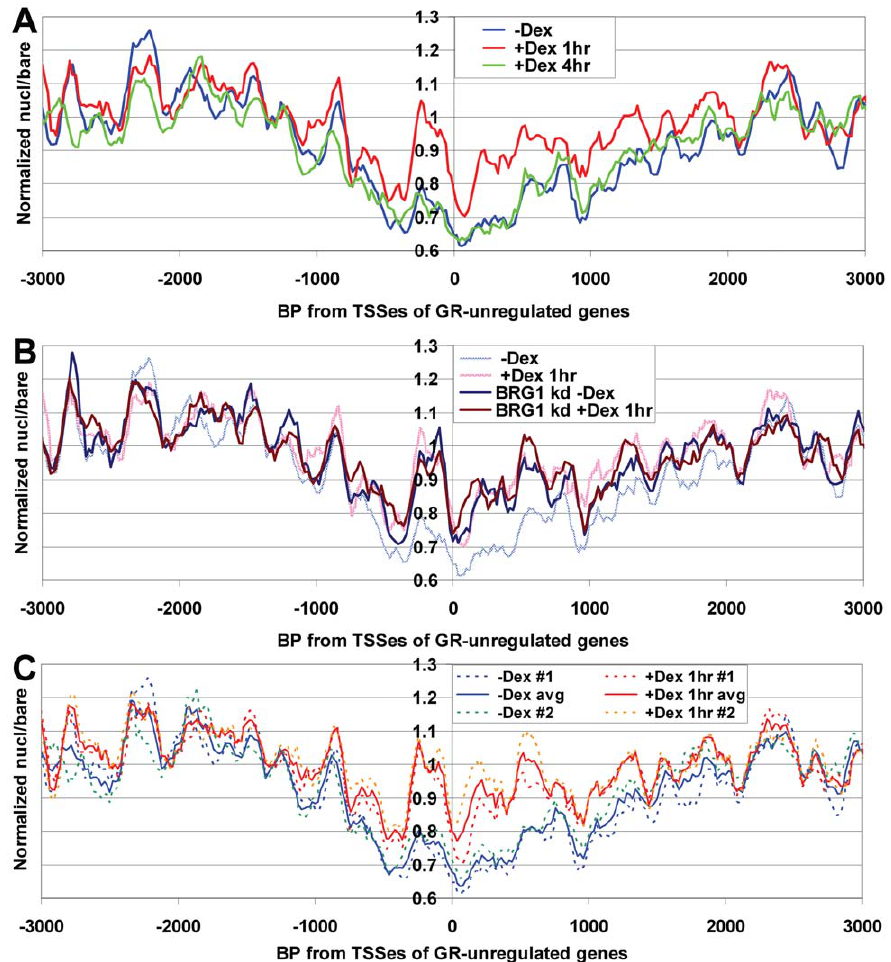
Figure 4. 1 hr Dex treatment increases nucleosome occupancy at GR-unregulated promoters. ( A ) & ( B ) As per Fig. 3, but showing average normalized nucl/bare ratios for all GR-independent genes on the array ( CCNA1, CCNB2, CCND1, CCNE1, CD44, CDK1, CDKN1A, CSF1, E2F1, GAPDH, UGT1A6 & UGT1A8 ). ( C ) –Dex or + Dex 1 hr results from biological replicate samples (dotted lines) and average from both samples (solid lines).